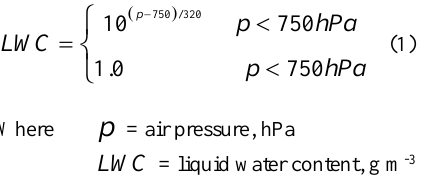
Figure 2. Ratio of zonal mean specific cloud water content and condensed moisture (shaded) and corresponding mean temperature (centigrade) in Jan. (a) and Jul. (b).